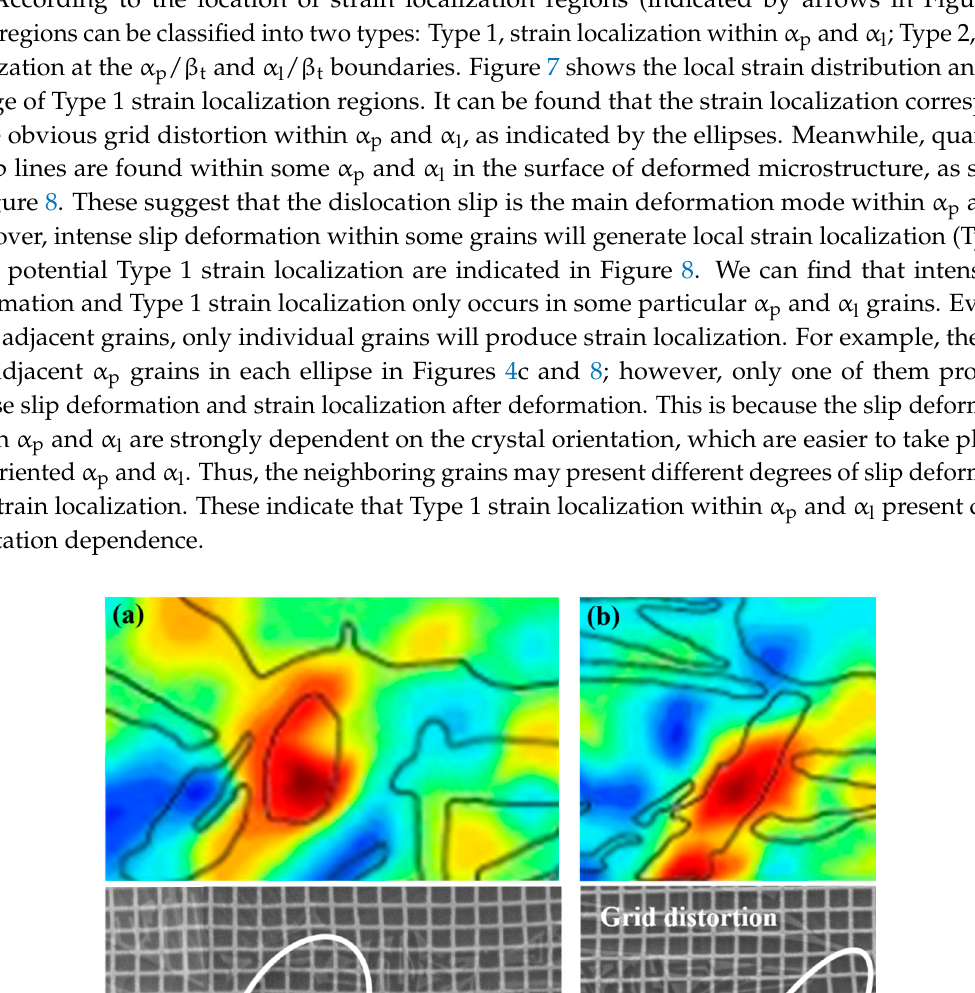
Figure 8. The morphology of deformed tri-modal microstructure after tensile deformation (the sample surface was mechanically and electrolytically polished before tensile deformation). As for Type 2 strain localization, the corresponding strain distribution and grid change are given in Figure 9. Obvious shift and fracture of microgrids are found at the boundaries of α p / β t and α l / β t , which implies the boundary sliding occurs in these regions. Barkia et al. [15] have also observed the boundary sliding at α p / α p boundary during the tensile deformation of CP titanium at room temperature. Similarly, Katani et al. [19] have also reported the shear deformation and fracture along α p / β t boundary during the tensile deformation of Ti-64 alloy at room temperature. The corresponding mechanism can be inferred from the corresponding features of deformed microstructure (Figure 8) as follows. Intense slip deformation is activated in the margin of softer α p and α l , while the neighboring β t is relatively hard to deform. Dislocations pile up at grain boundaries and some of them are absorbed by grain boundaries. The absorbed dislocations will slip along interface under shear stress, which then lead to the boundary sliding and shows the bright white stripe (indicated by yellow arrows in Figure 8). On the other hand, it can be found that the included